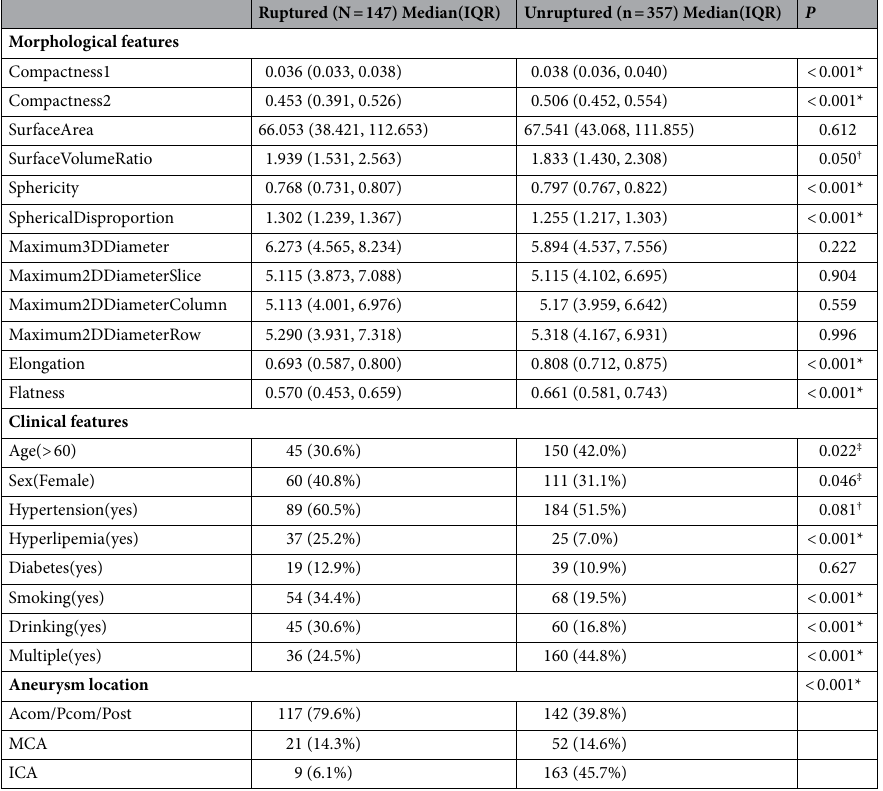
Table 2. Comparison of the features between ruptured and unruptured aneurysms in the training set. IQR interquartile range, Acom anterior communicating artery, Pcom posterior communicating artery, Post posterior circulation, MCA middle cerebral artery, ICA internal carotid artery. * P < 0.001, † P < 0.1, ‡ P < 0.05.